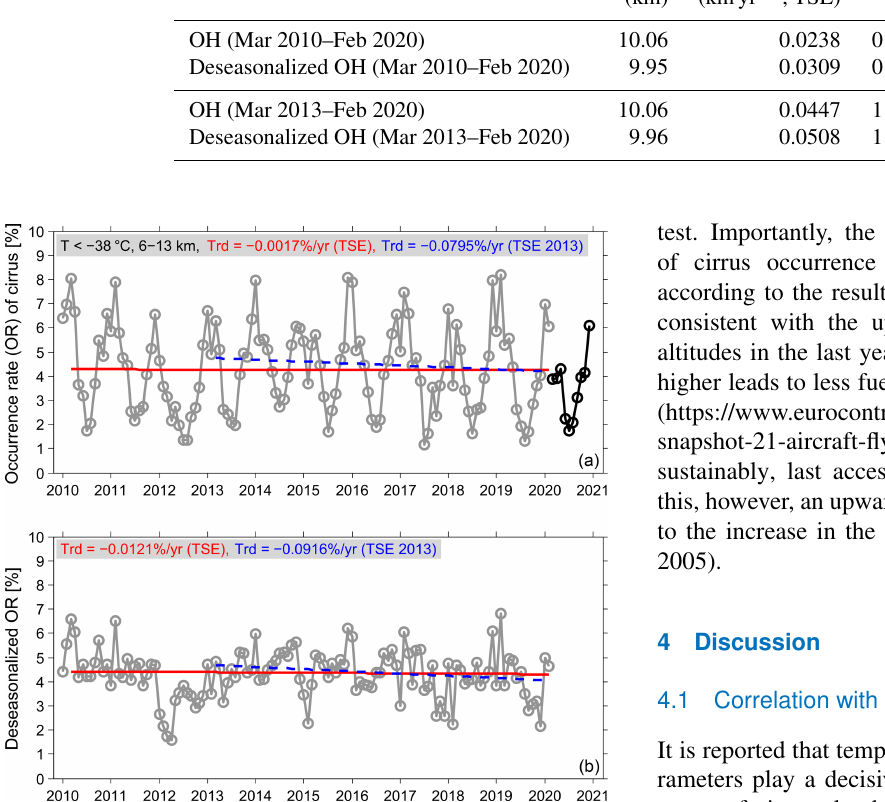
Figure 6. Long-term variations in monthly occurrence rate (OR) of cirrus clouds in the period 2010–2020 as well as the linear fitting for the values in the periods from March 2010 to February 2020 (in red) and from March 2013 to February 2020 (in blue). The ORs of cirrus clouds during the COVID-19 pandemic are shown in black for comparison. The corresponding trends (i.e. the slopes) are indi- cated on the plot: panel (a) for the derived monthly OR from all the data including day- and night-time; panel (b) for the deseasonalized time series of